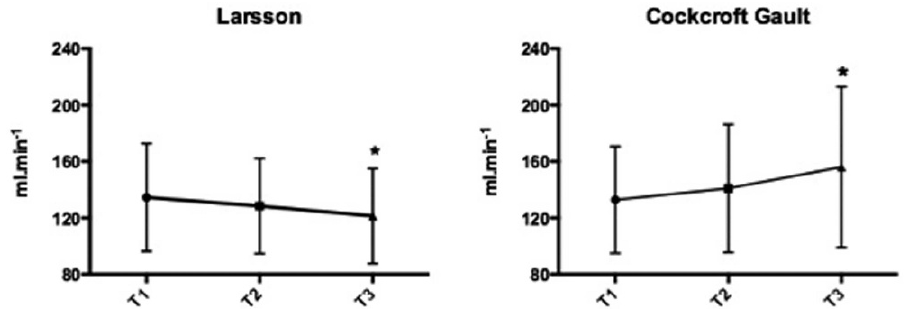
Figure 5 - The glomerular filtration rate calculated using Larsson’s formula (mean ¡ standard deviation) and the glomerular filtration rate calculated using the Cockcroft-Gault formula (mean ¡ standard deviation) at baseline (T1), 30 minutes after abdominal insufflation (T2), and 30 minutes after the end of the pneumoperitoneum (T3). * p , 0.05 versus baseline values.